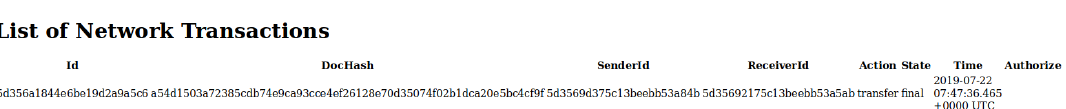
Figure 7. List of completed Transactions. The status of the transactions is maintained and updated by the index server.